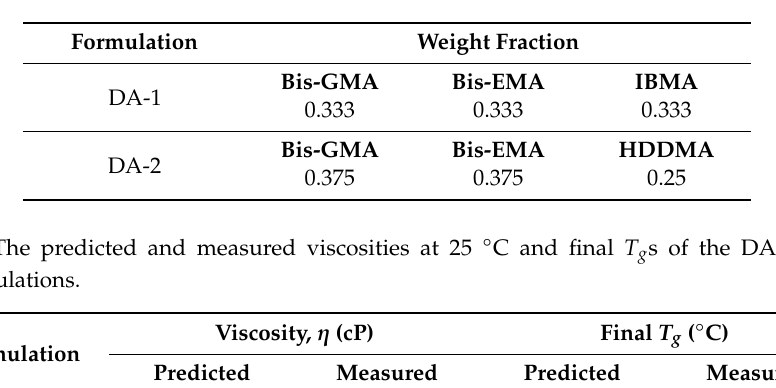
Table 3. The DA-1 and DA-2 formulations.